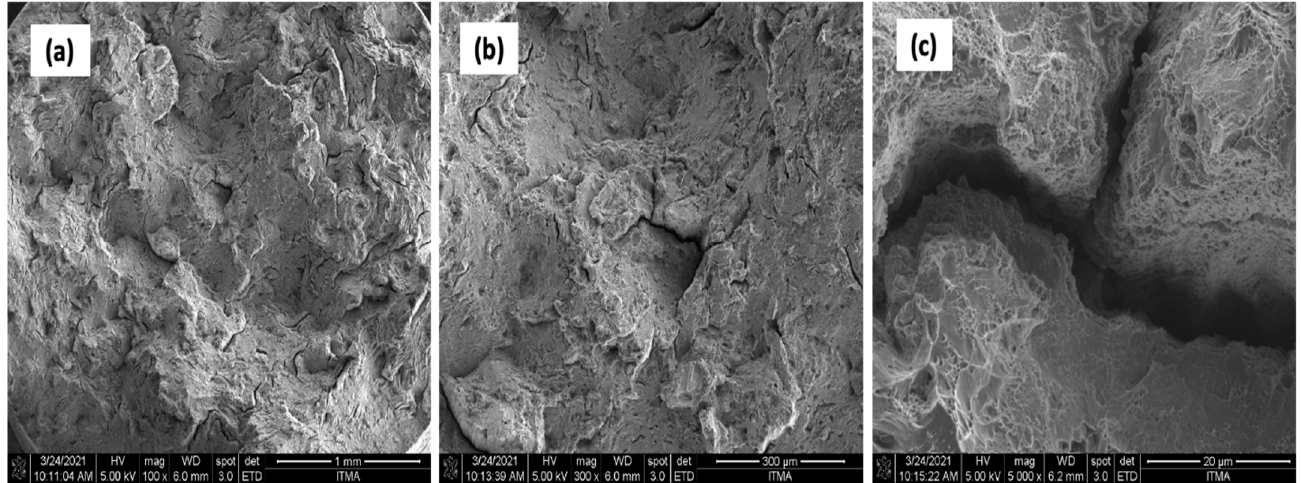
Figure 19. AA7075 1% vol ZrO 2 /HT ( a ) 100× ( b ) 300× ( c )